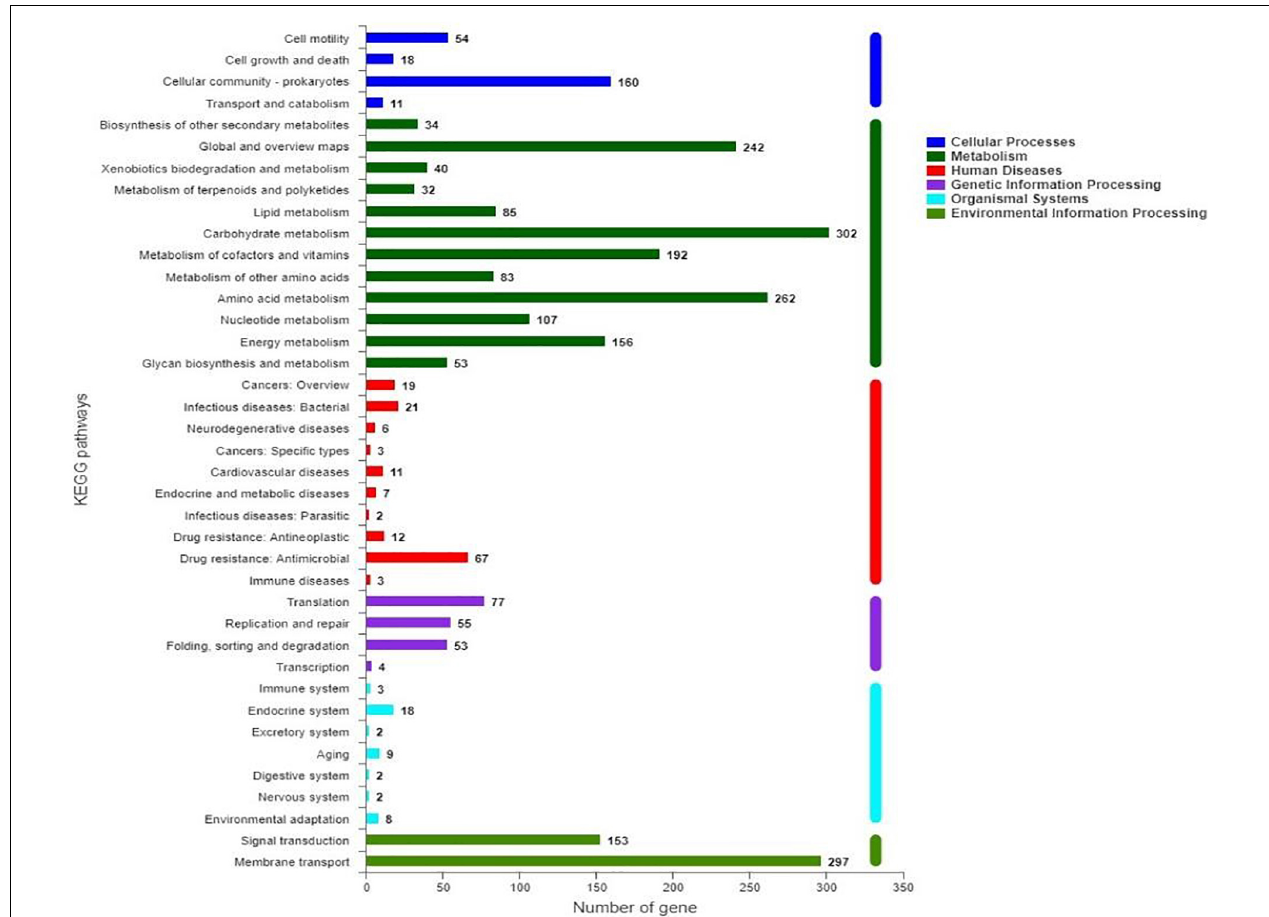
FIGURE 5 | Classification of KEGG pathways of predicted genes in S. marcescens JW-CZ2 genome.